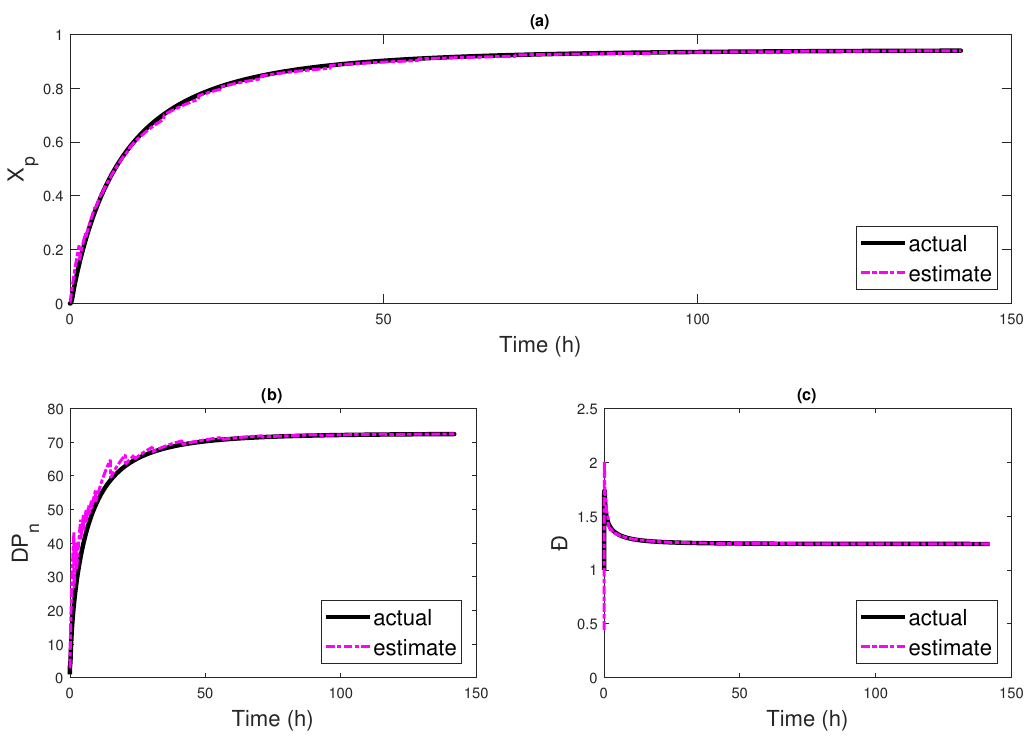
Figure 8. Test of observer performance against the model for ( a ) monomer conversion X p ; ( b ) number average molecular weight DP n , ( c ) dispersity Ð